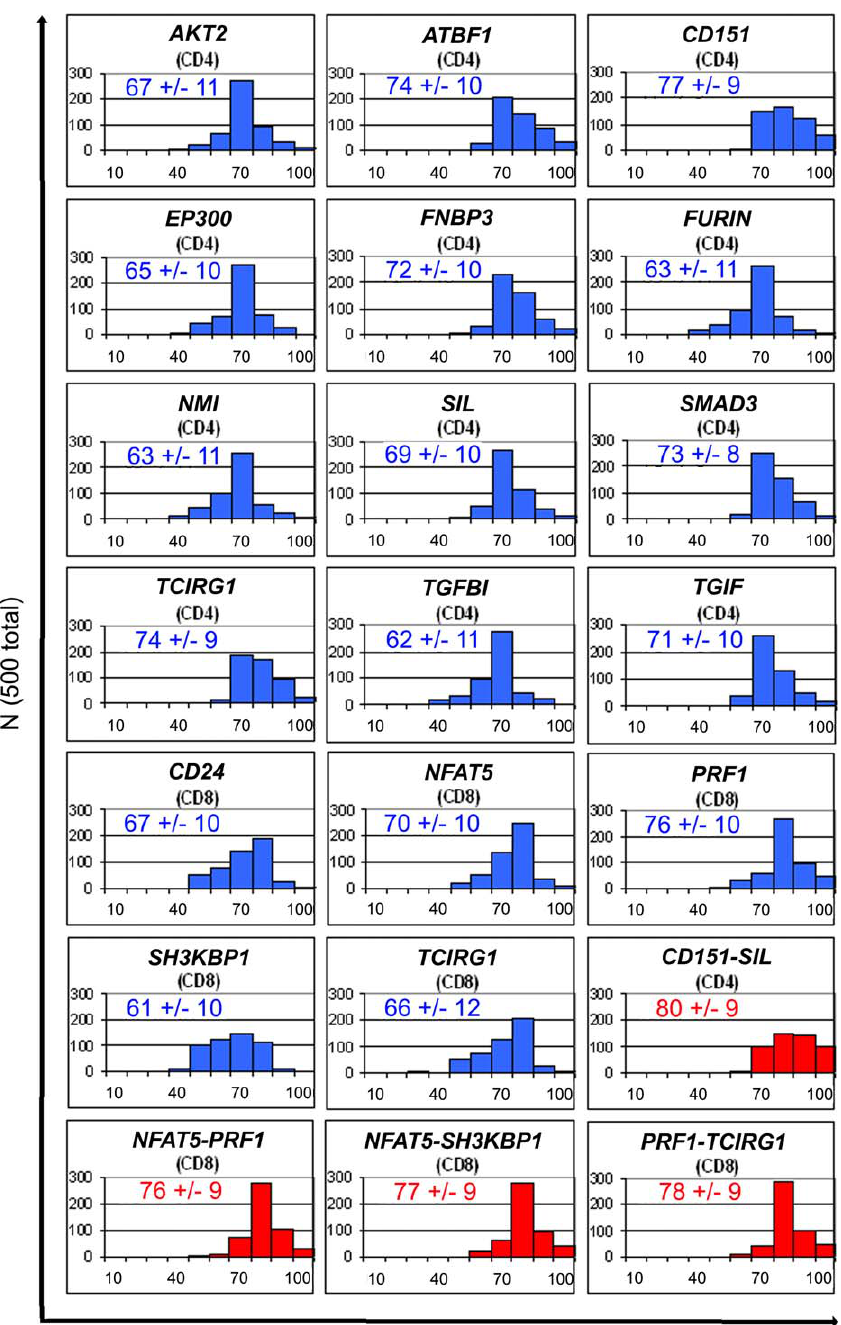
Figure 5. Multiple Training-Test Dataset Split Cross-Validation For each single gene ( n ¼ 17, blue) and gene pairs ( n ¼ 4, red), we carried out 500 different 60% training samples and 40% test samples dataset splits by randomly assigning 60% of the respective cGVHD þ and cGVHD (cid:2) samples to a training dataset and the remaining 40% of the samples to the